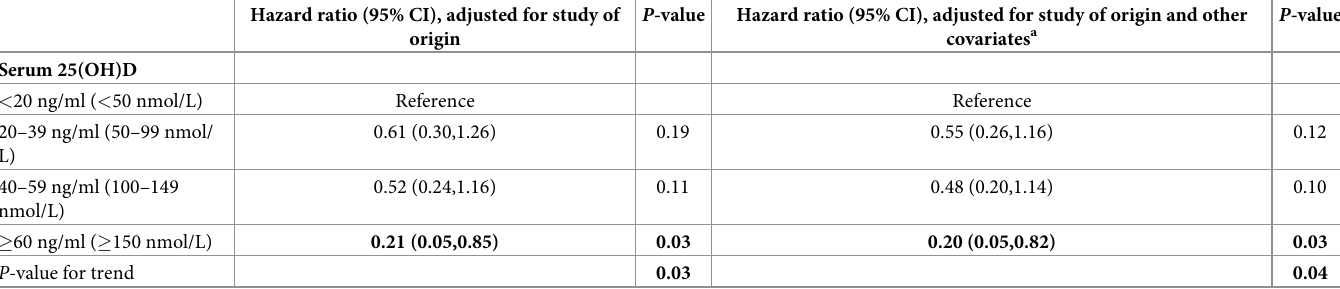
Table 2. Association between serum 25(OH)D and risk of breast cancer, pooled cohort (N = 5038).